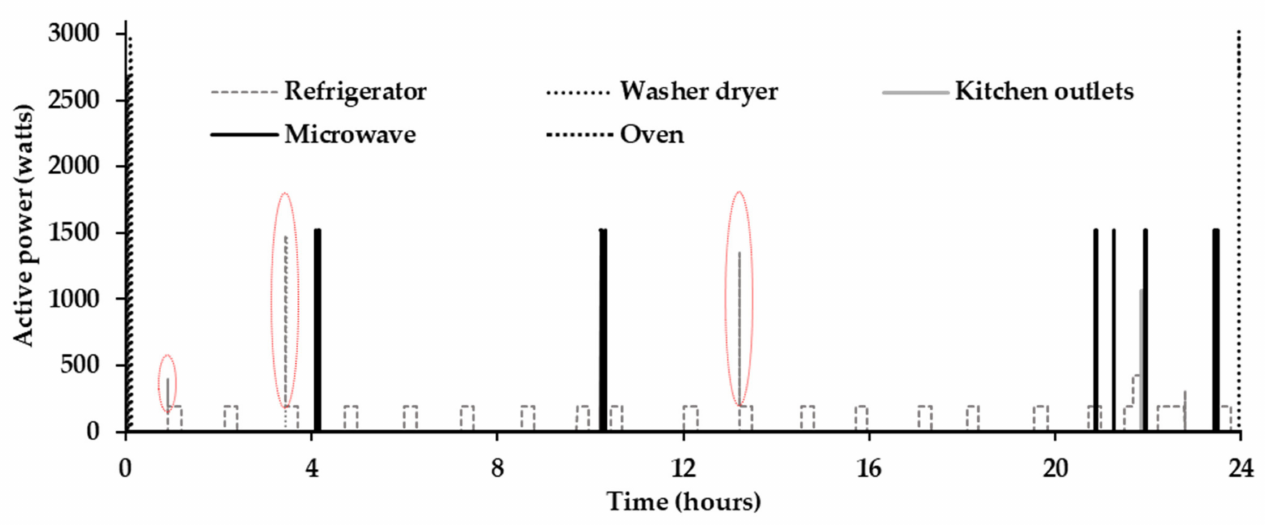
Figure 6. Estimated ALDs for testing data 2 after post-processing (dotted elliptical shapes represent some samples where transient powers are assigned to the